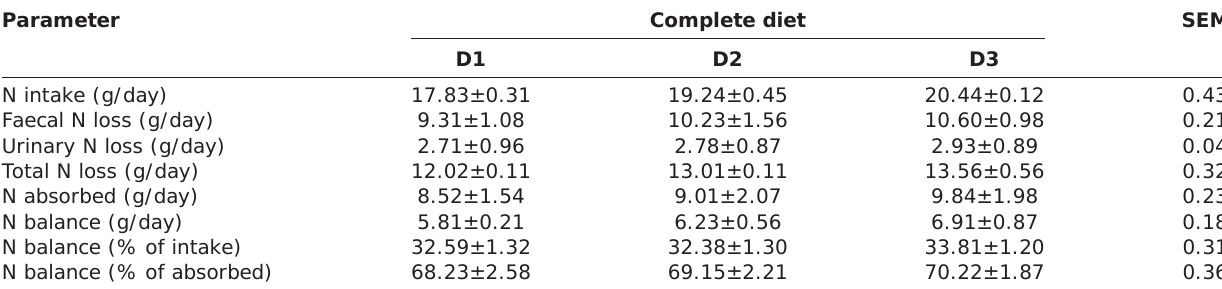
Table-5: Effect of feeding different stover based complete diets on nitrogen balance in Nellore ram lambs.